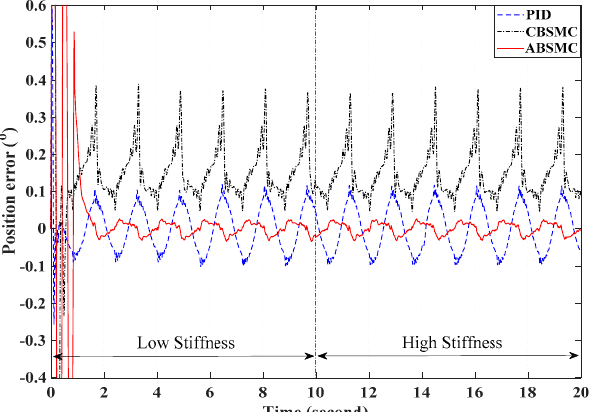
Appl. Sci. 2019 , 9 , x FOR PEER REVIEW Figure 8. The angle error responses of the PID control, the CBSMC, and the proposed ABSMC.